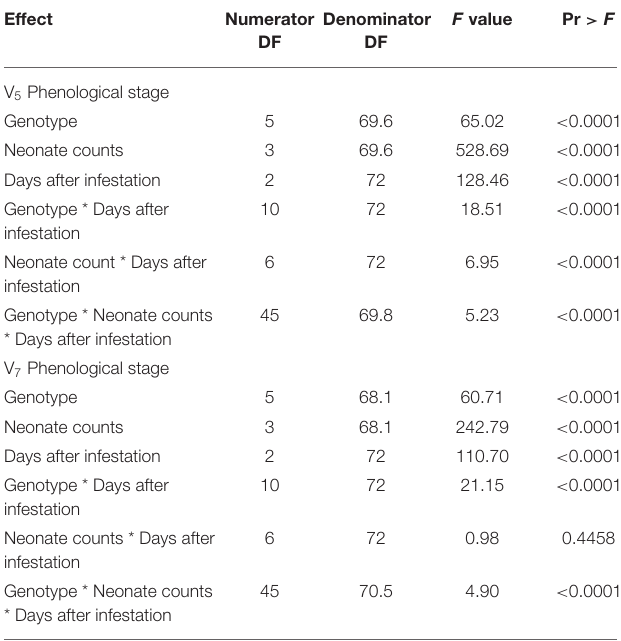
TABLE 3 | ANOVA for the Least Square means of three-way interaction (Genotype, Neonate counts, and Days after infestation) in net house conditions.